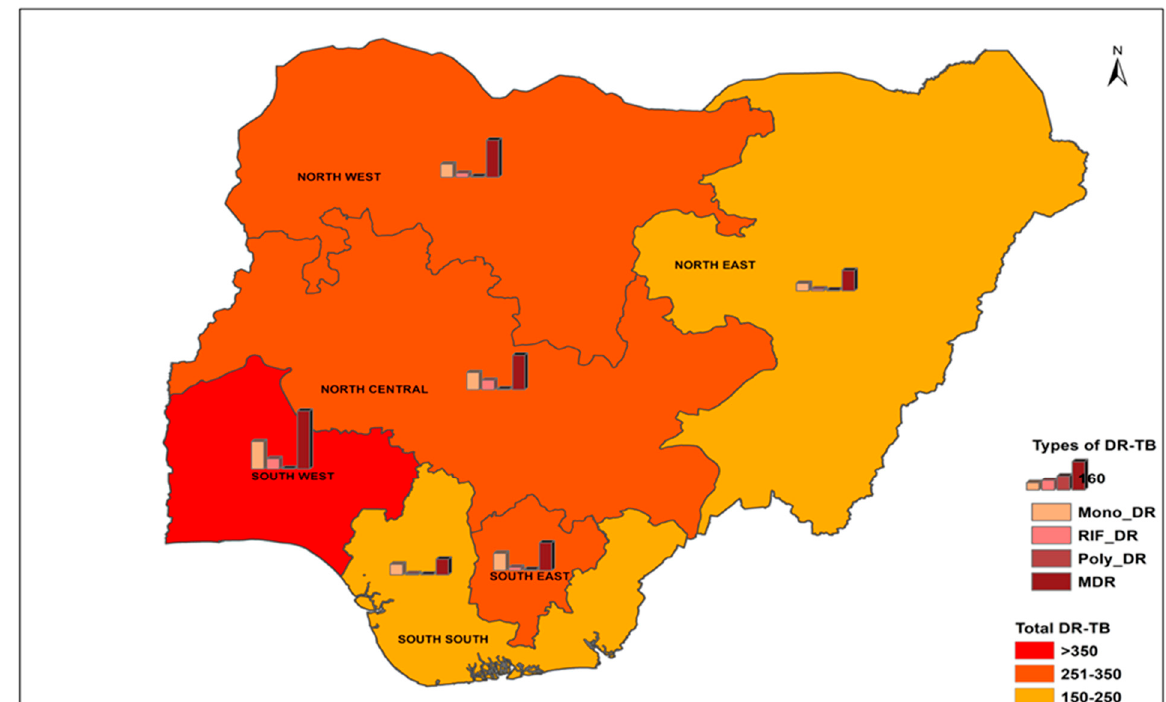
Figure 1. Trend of the pattern of presentation of laboratory-confirmed DR-TB cases by year (2010– 2016).